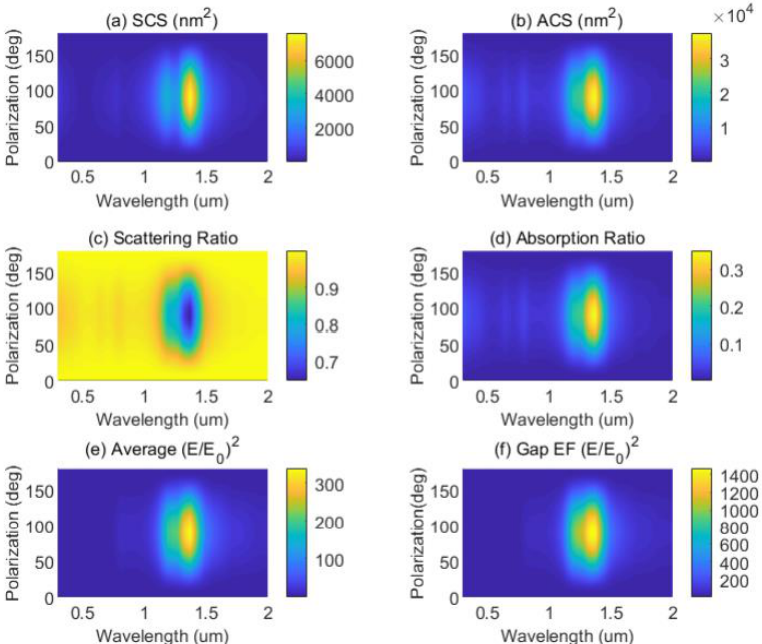
Figure 6. The scattering cross section, absorption cross section, scattering ratio, absorption ratio, average enhancement factor over the simulation object, and average enhancement factor over the gap for the PGNB on a flat sapphire substrate depend on polarization angle and incident wavelength of the source. The incident light source, with a wavelength range between 0.3 µ m and 2 µ m and at various polarization angle, was illuminated on the PGNB vertically. ( a , b ): the scattering cross section and the absorption cross section of the PGNB depend on polarization angle and wavelength of the incident light source, respectively; ( c , d ): the scattering ratio and the absorption ratio of the PGNB depend on polarization angle and wavelength of the incident light source, respectively; ( e , f ): the average enhancement factor over the simulation object and the average enhancement factor over the gap of the PGNB depend on the polarization angle and wavelength of the incident light source,